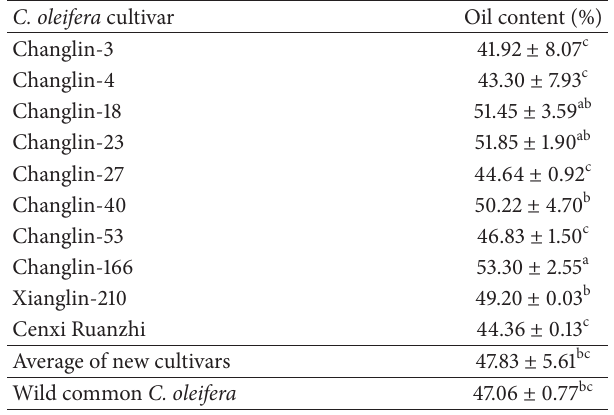
Table 1: Oil contents of different C. oleifera